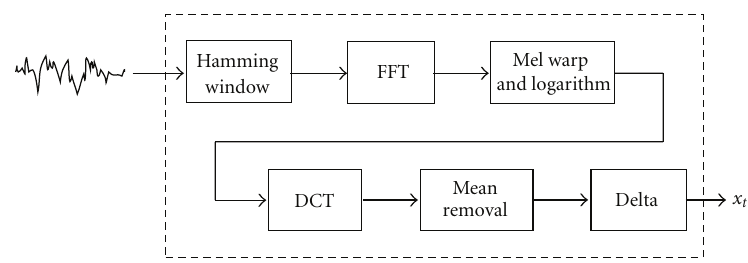
Figure 2: MFCC feature extraction block